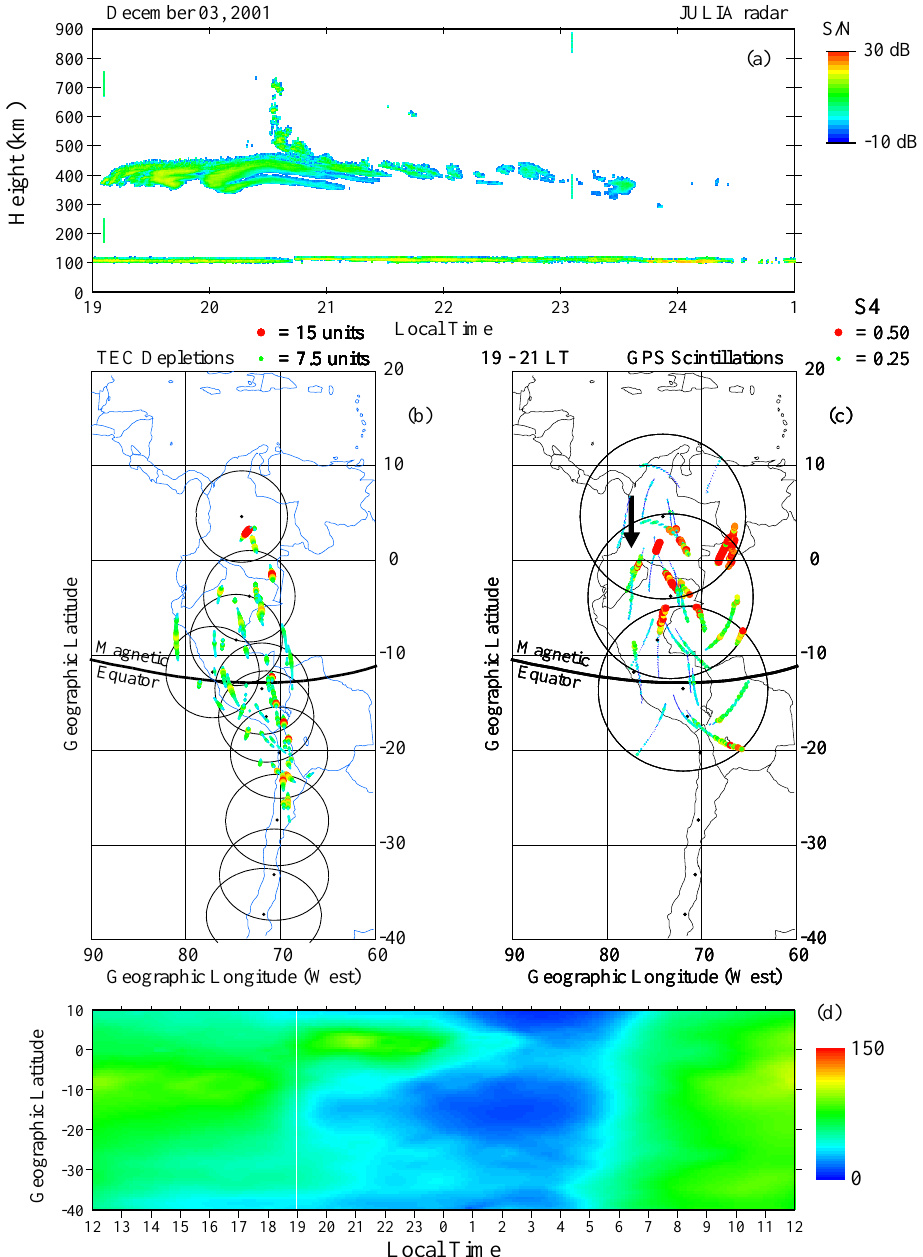
Fig. 5. Same as Fig. 4, but corresponding to 3 December 2001. The top panel shows a single radar plume developing at 20:40 LT, and reaching 700km. The TEC depletion and the GPS scintillations, at locations near Jicamarca, extend up to 13 ◦ magnetic latitude. The TEC profiles seen near sunset are highly asymmetric. Nevertheless, strong scintillations were detected this